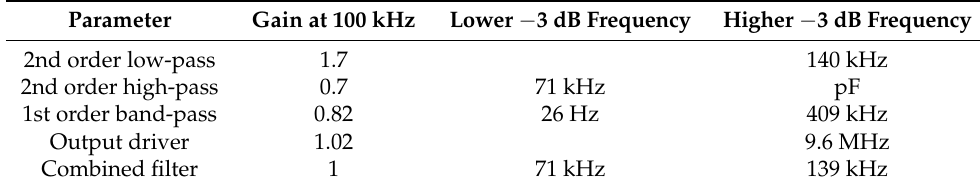
Figure 8. Amplitude–frequency characteristic curve of the band-pass filter. Table 1. Parameters of the third-order band-pass